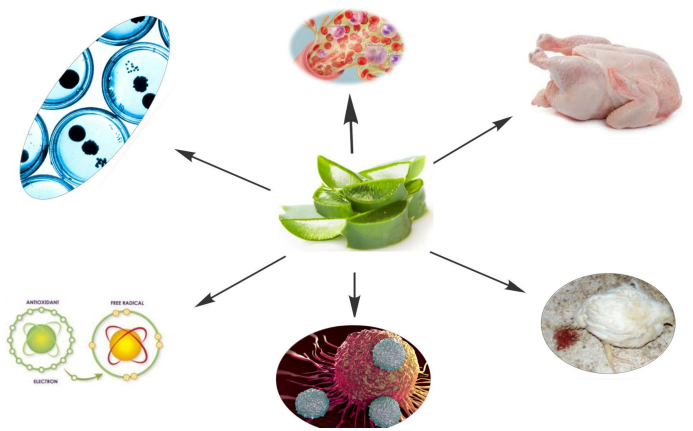
Figure 2. Multiple beneficial effects of Aloe vera in poultry.